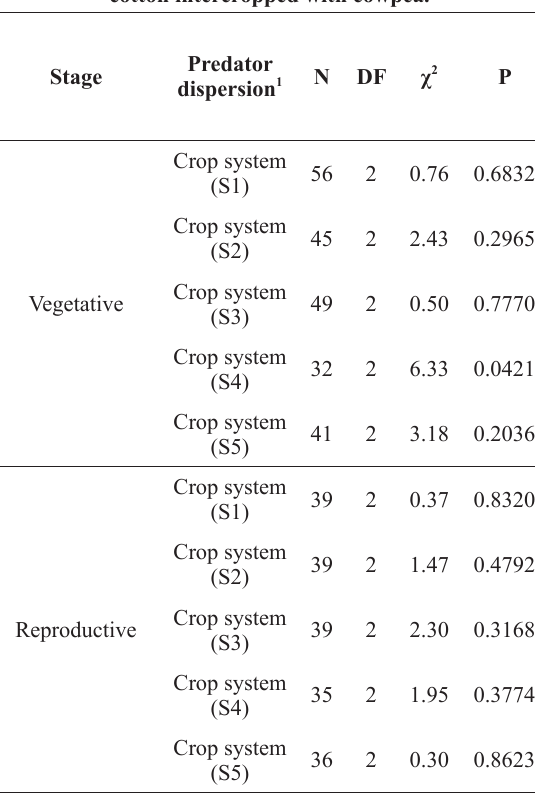
Dispersion of Cycloneda sanguinea (Coleoptera: Coccinellidae) in the crop systems of cotton, cowpea and cotton intercropped with cowpea.